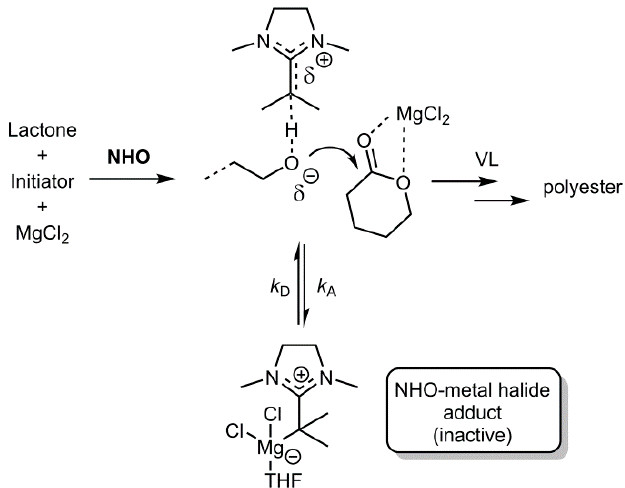
Scheme 1. Simplified reaction mechanism for the cooperative activation of